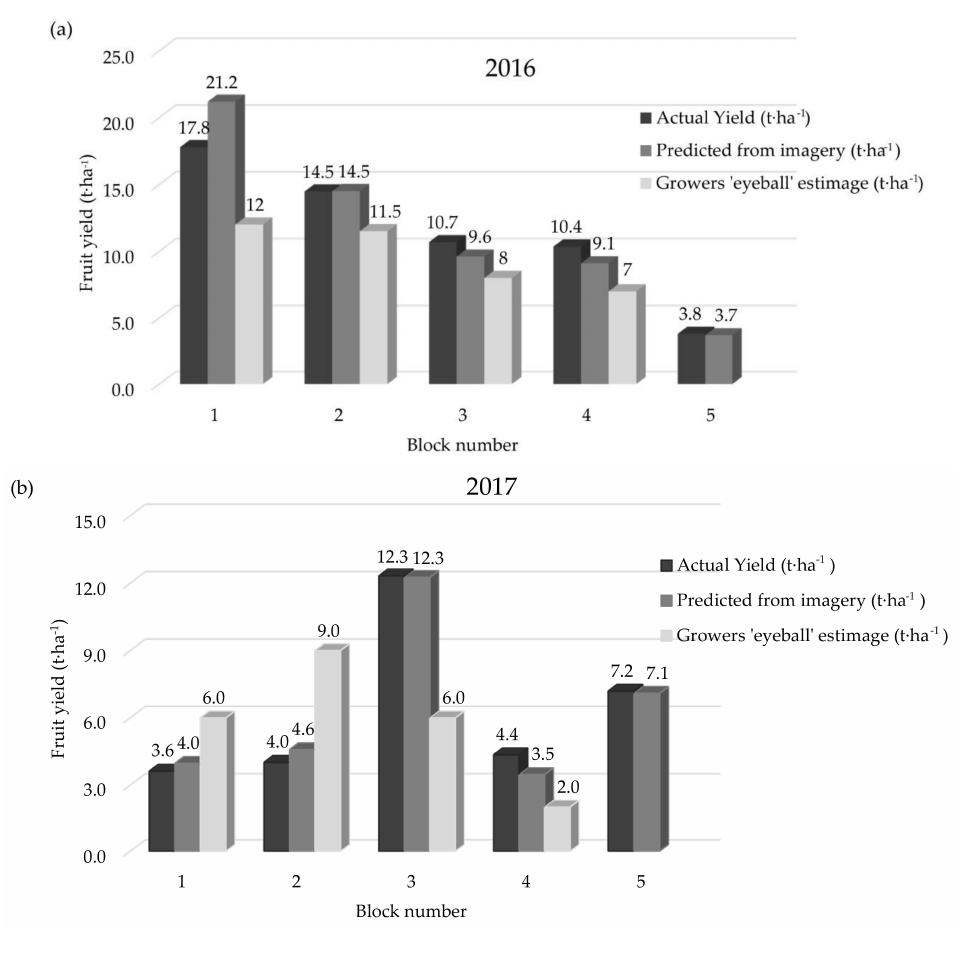
Figure 7. Comparison between the actual yield (t · ha − 1 ) to that predicted from satellite imagery and that made by visual assessment from growers in ( a ) 2016 and ( b ) 2017. Note that no growers estimate was supplied for Block